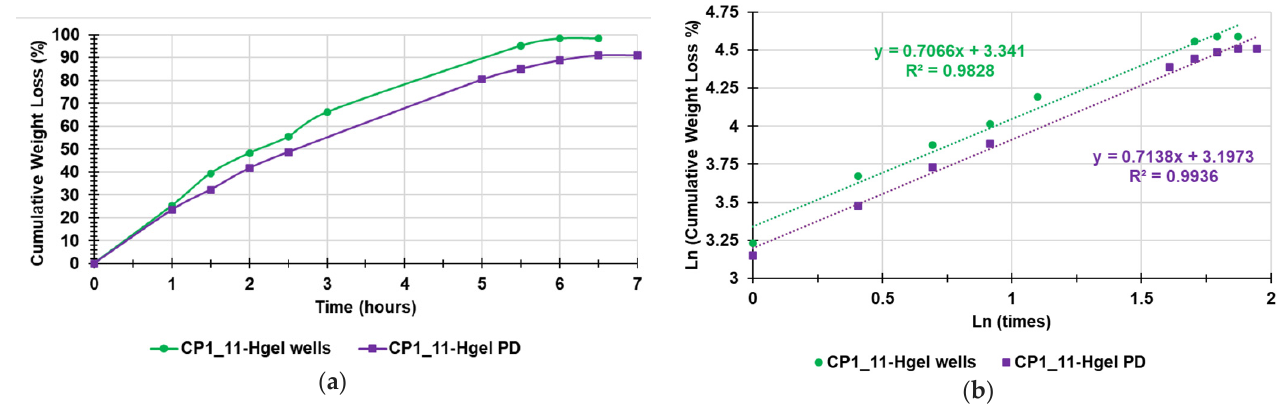
Figure 6. Cumulative weight loss percentage curves of the gel into Ws (green line) and of the gel contained in the PD used to prepared it and described in Section 3.2. (purple line) ( a ); Korsmeyer– Peppas kinetic models fitting data of cumulative weight loss curves ( b ).